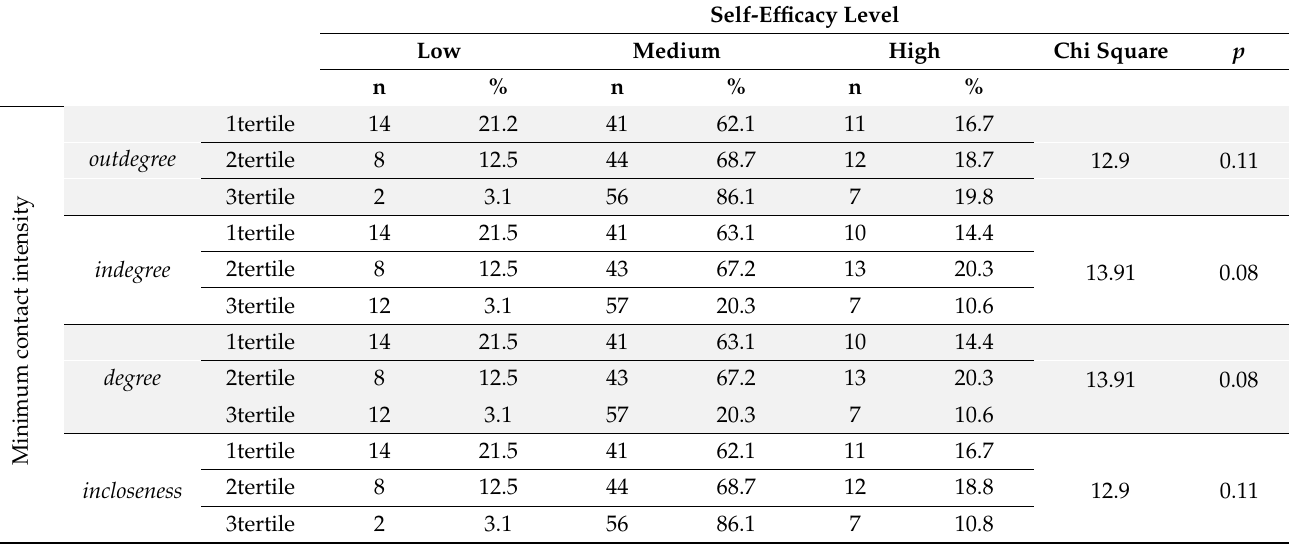
Table 2. Centrality indicators in relation to self-efficacy. (In Minimum contact